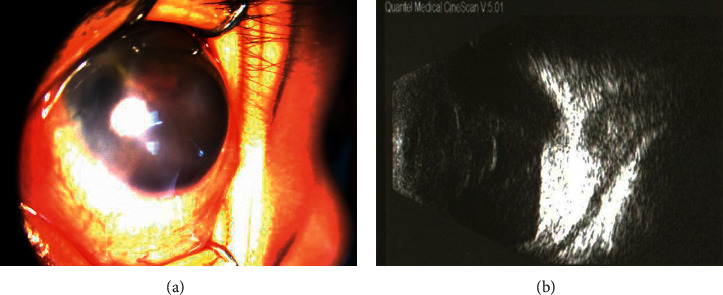
Right eye of case 4. (a) Flat anterior chamber. (b) B-scan of the right eye showed funnel-form retinal detachment.